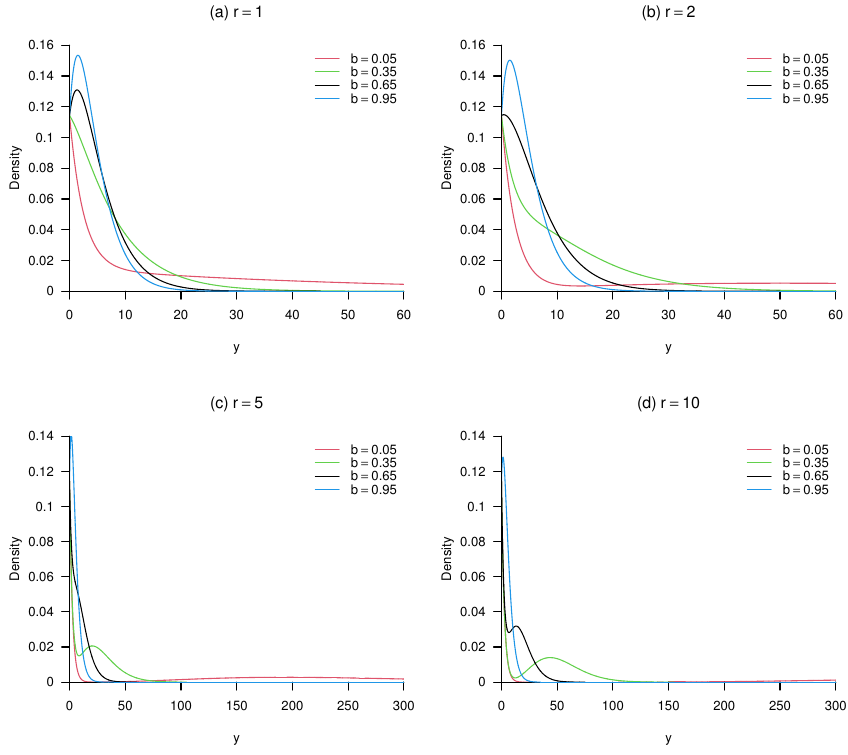
Figure 2. Shapes of the density function (6) for different values of ( b , r ) and β =